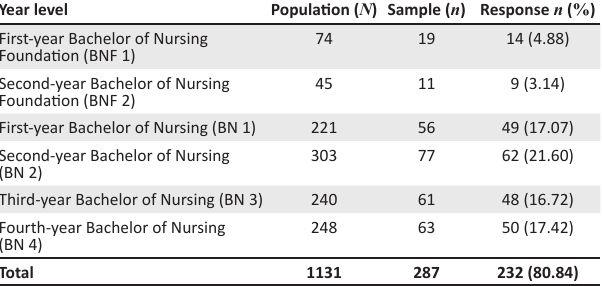
TABLE 1: Summary of study population, sample and response